Question: Which kind of chart has been used to present this data?
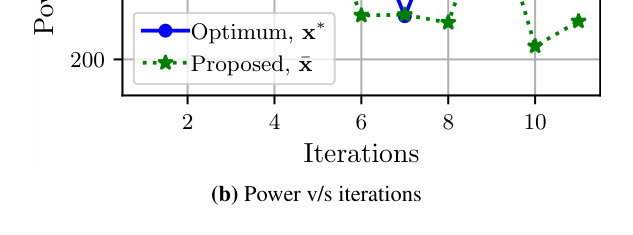
Answer: line